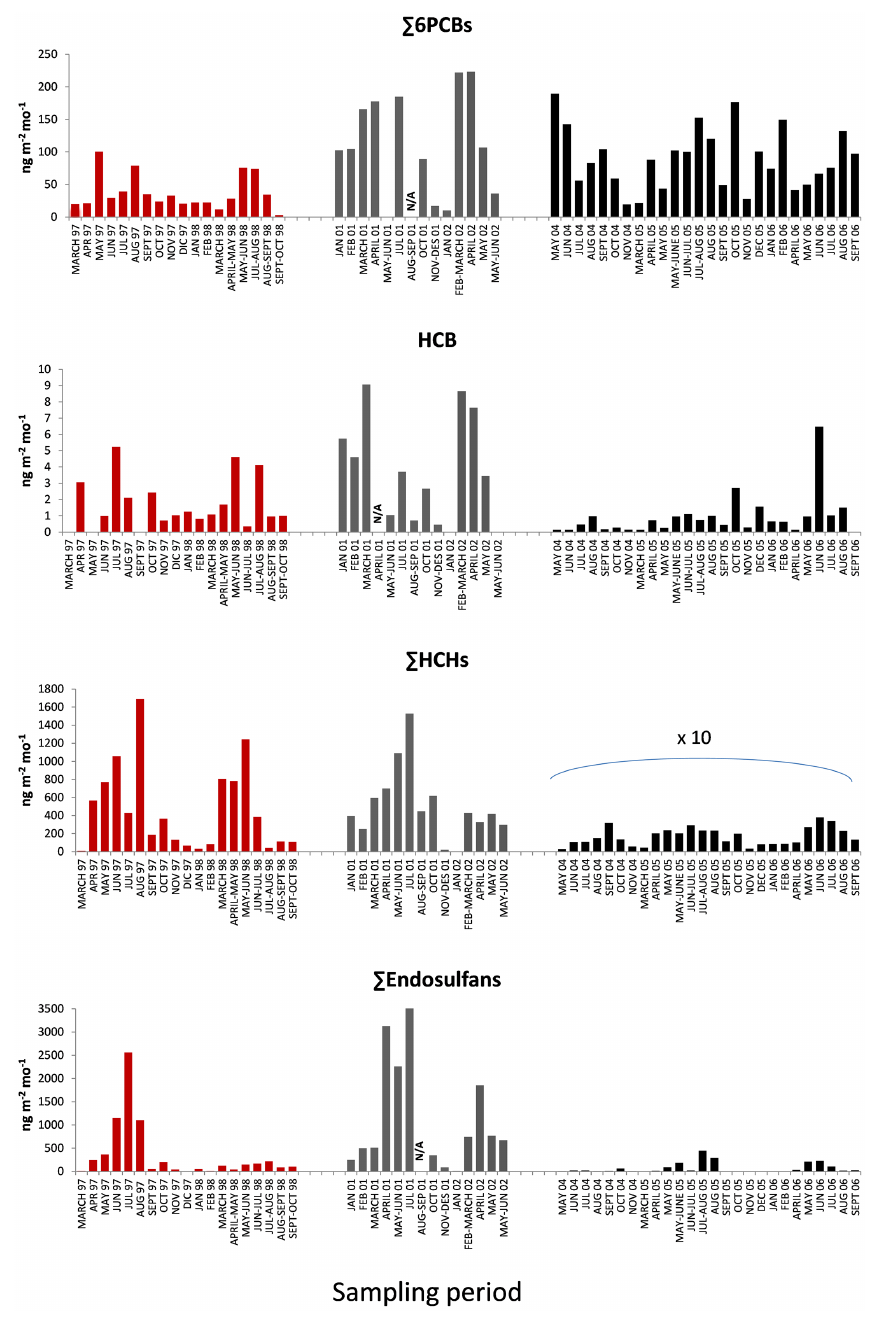
Figure 3. Temporal trends of OC concentrations in bulk atmospheric deposition samples from Redòn. N/A means not available. P 6PCBs, sum of PCB 28, 52, 101, 118, 153 and 180. P HCHs, sum of α -HCH and γ -HCH. P Endosulfans, sum of α -endosulfan, β -endosulfan and endosulfan